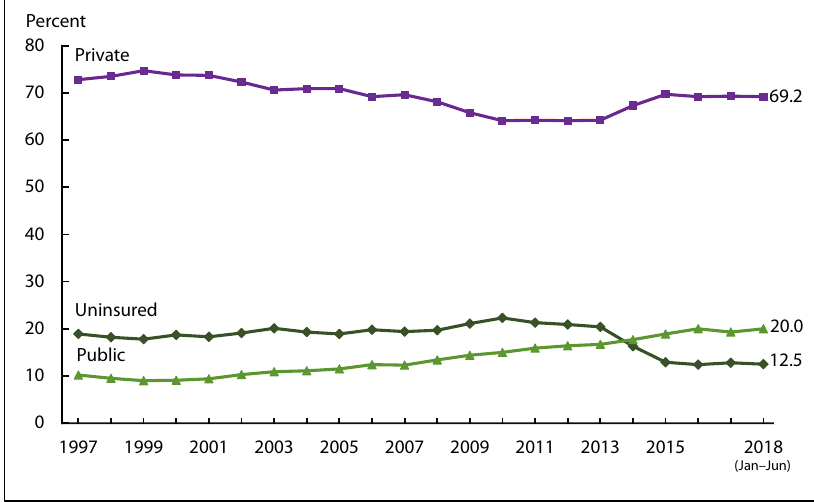
Figure 1. Percentage of adults aged 18 – 64 who were uninsured or had private or public coverage at the time of interview: United States, 1997–June